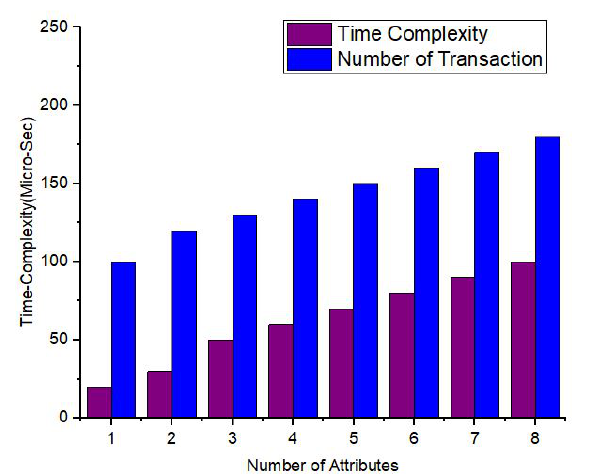
Figure 20. Comparative Analysis of Cross-domain using Homomorphic